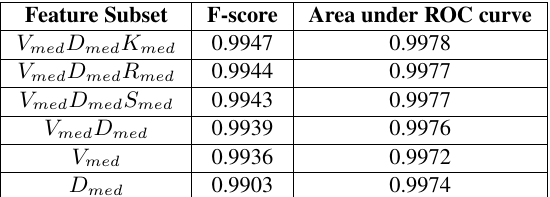
Table 3: Evaluation results for feature